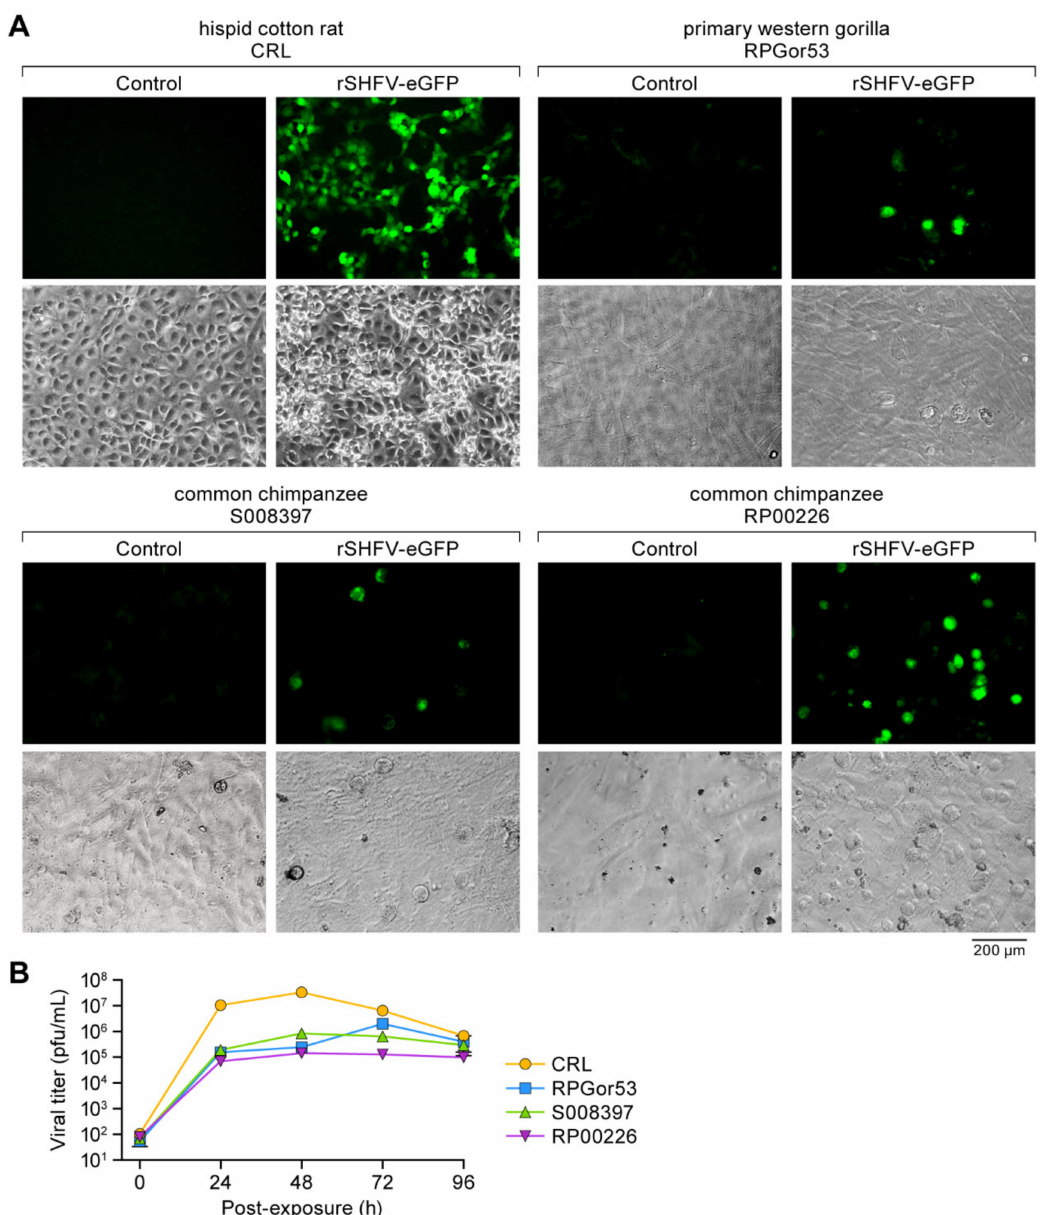
Figure 5. Cellular tropism of simian hemorrhagic fever virus (SHFV): Recombinant wild-type SHFV expressing enhanced green fluorescent protein-expressing (rSHFV-eGFP) infects hispid cotton rat lung (CRL) cells, western gorilla RPGor53 primary fibroblasts, and chimpanzee S008397 and RP00226 primary fibroblasts. ( A ) CRL cells, western gorilla primary fibroblasts, and common chimpanzee primary fibroblasts were exposed to rSHFV-eGFP at a multiplicity of infection (MOI) of 3. eGFP expression and cytopathic effect were observed at 24 h post-exposure. ( B ) Cells were exposed to wild-type SHFV at an MOI of 3. Tissue culture supernatants were harvested at the indicated time points post-exposure, and virus titers were determined by plaque assay. Graphs of viral titers represent the means ± the standard deviations of triplicate samples from one of two independent